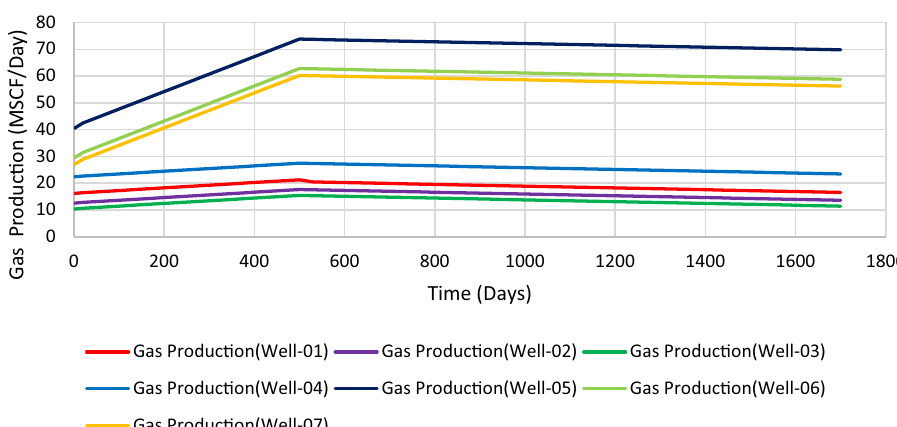
Fig. 7 Gas production rate for each